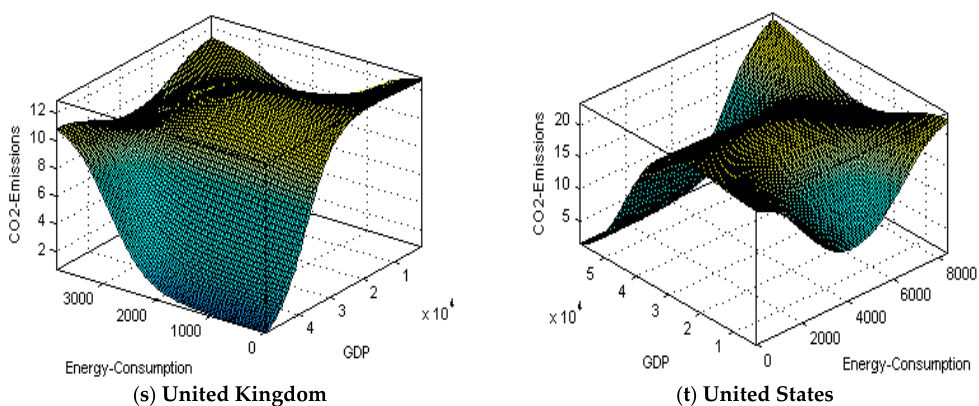
Figure 3. CO 2 Emissions Prediction based on Economic growth and Energy Consumption for G20 Countries.